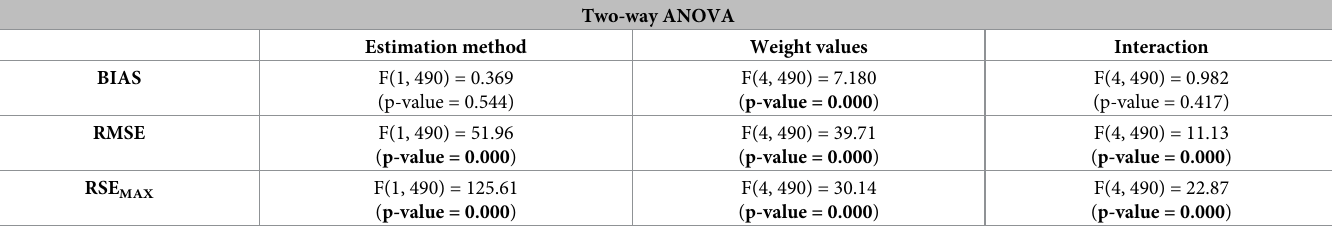
Table 8. Two-way ANOVA using data generated in scenario